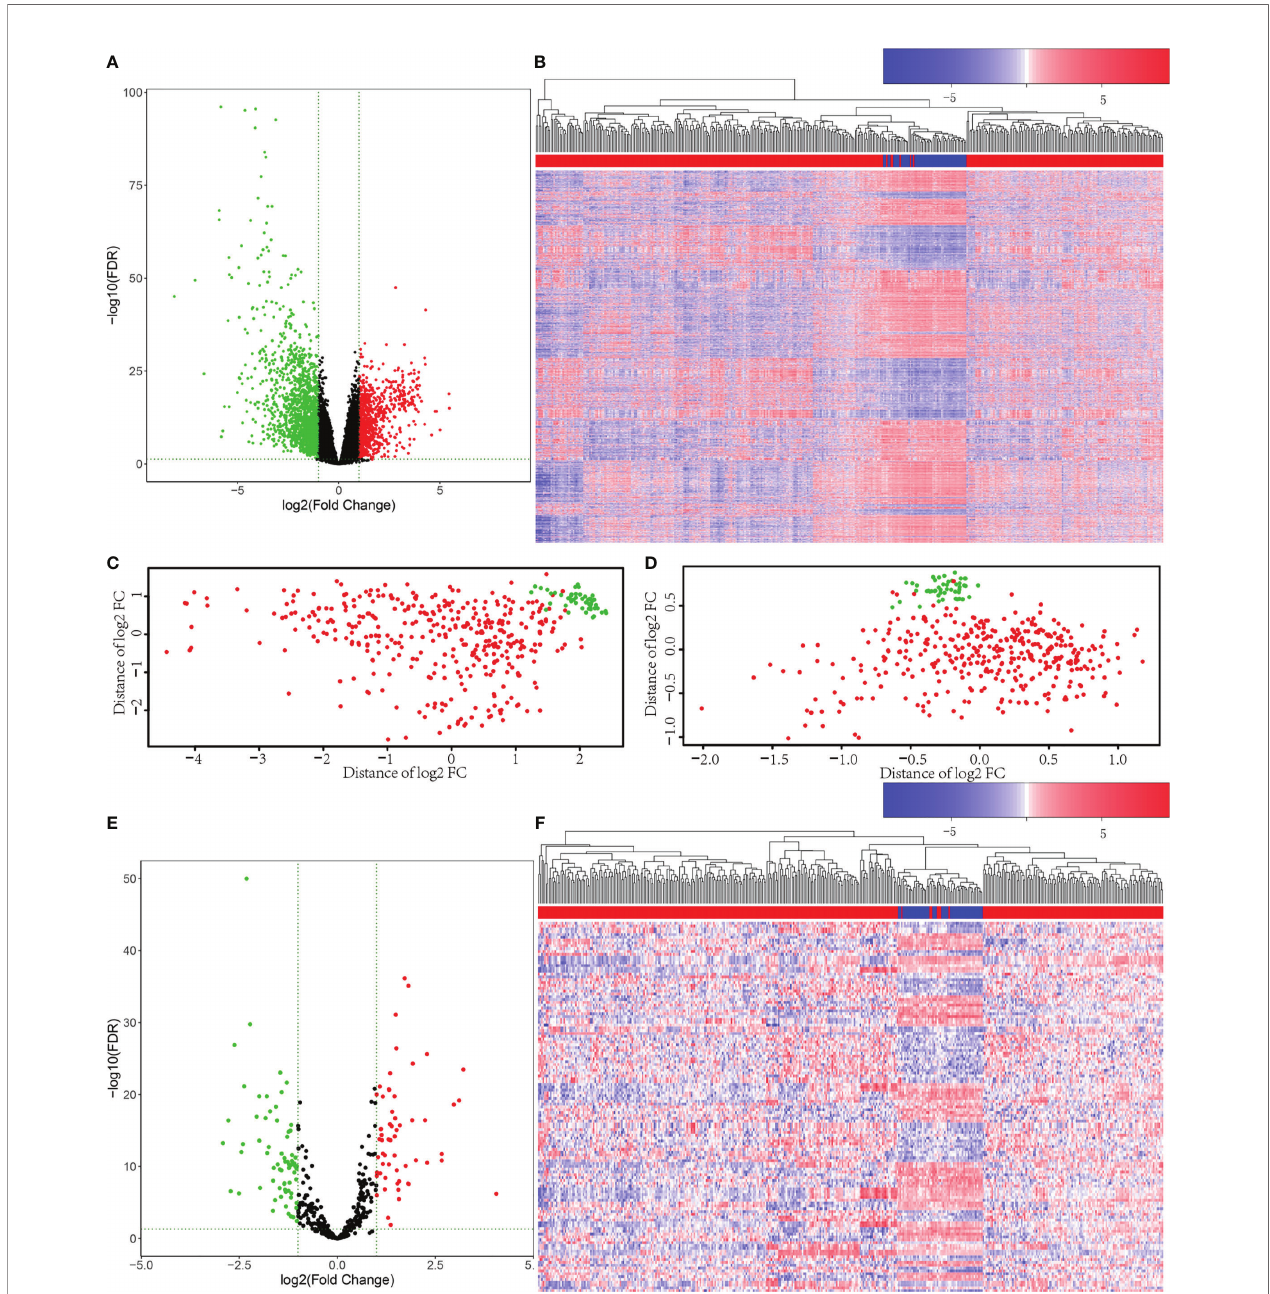
FIGURE 1 | Differentially expressed mRNAs and miRNAs were selected from The Cancer Genome Atlas (TCGA) database. (A) Volcano plots for 2,416 differentially expressed genes (DEGs). The green dots represent downregulated genes, and the red dots represent upregulated genes. Black dots represent genes without statistically signi fi cant change (p < 0.05 and |log2 fold change|>1). (B) Heatmap for DEGs in primary tumor (red) compared with solid tissue normal (blue). (C) The principal component analysis (PCA) fi gure of the samples based on the differentially expressed mRNAs. (D) The PCA fi gure of the samples based on the differentially expressed miRNAs. (E) Volcano plots for the 131 Differentially Expressed microRNAs (DEmiRs). The green dots represent downregulated miRNAs, and the red dots represent upregulated miRNAs. Black dots represent miRNAs without statistically signi fi cant change (p < 0.05 and |log2 fold change|>1). (F) Heatmap for DEmiRs in primary tumor (red) compared with solid tissue normal